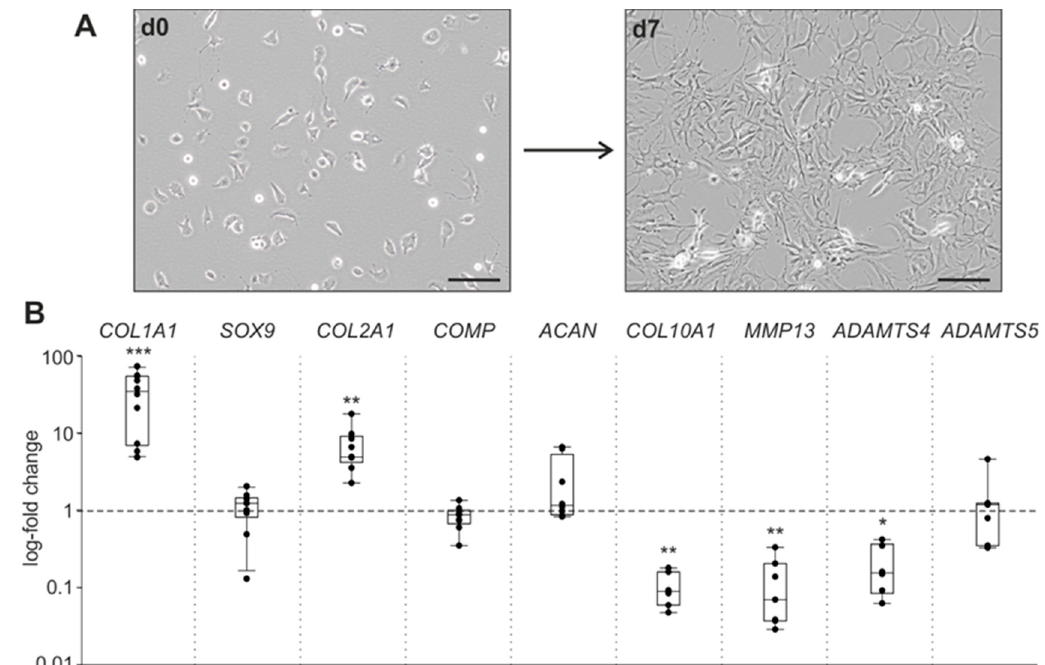
Figure 1. Chondrocyte phenotype shift during dedifferentiation under physioxia. ( A ) Change of human osteoarthritis (OA) chondrocytes from a polygonal to a fibroblast-like morphology after seven days under physioxic conditions (representative images of chondrocytes isolated from one OA patient, magnification 200 × , scale bars represent 100 µ m). ( B ) Gene expression changes of the transcription factor SOX9, ECM components, and ECM-degrading enzymes after seven days in monolayer culture under physioxic conditions compared to day 0 (gene expression on day 0 = 1, represented by the dashed line). All experiments were carried out with cells from 8–10 patients, using duplicates for each patient. Each circle shows the mean of the duplicates. Data are presented as box plots, where the boxes represent the 25th to 75th percentiles, the lines within the boxes represent the median, and the lines outside the boxes represent the 10th and 90th percentiles. Significant p -values against day 0 are presented as: * ( p ≤ 0.05), ** ( p ≤ 0.01), *** ( p ≤ 0.001).